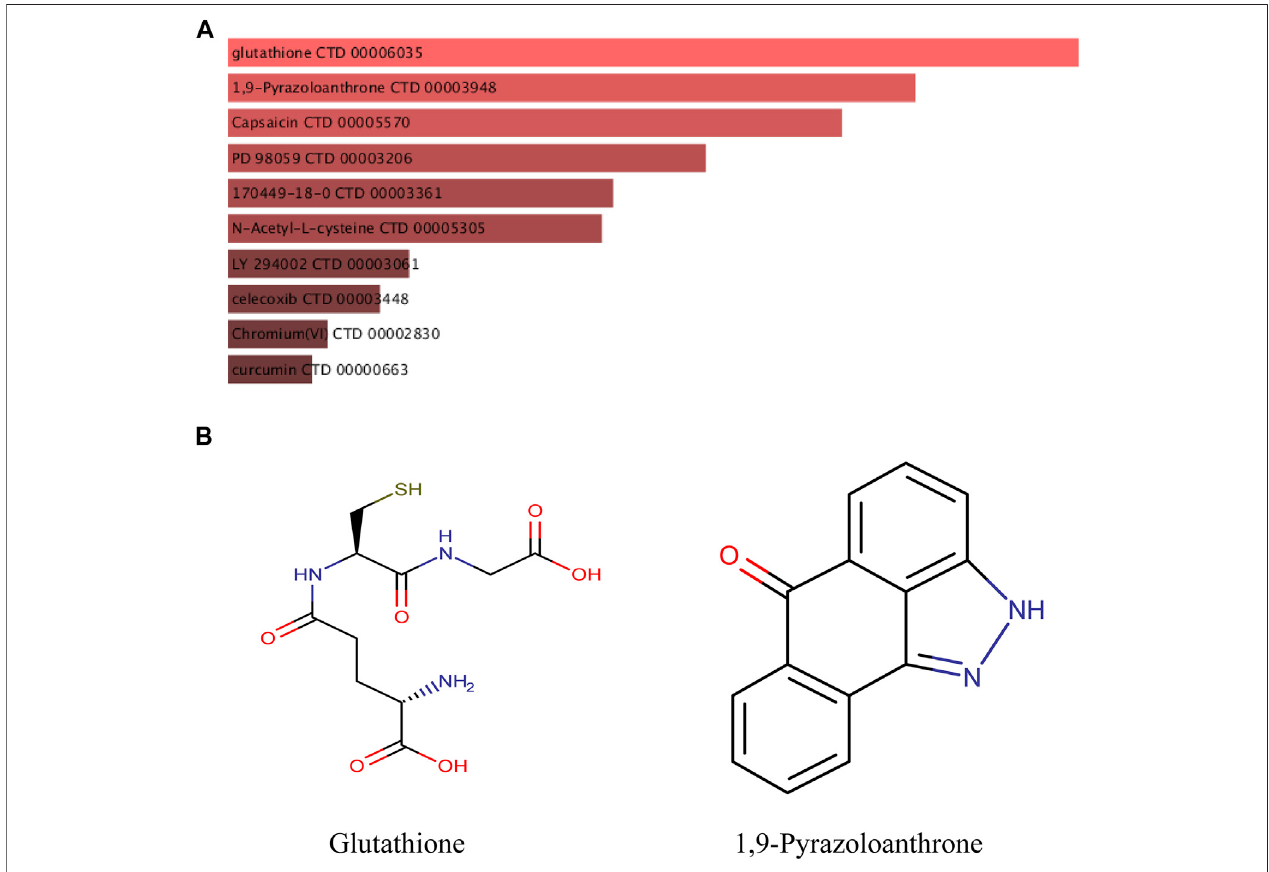
FIGURE6| Targeteddrugsprediction. (A) Thetop10predictedtargetdrugsrankedaccordingto p valuesintheDSigDBdatabase. (B) Thechemicalstructuresof glutathione and 1,9-Pyrazoloanthrone.